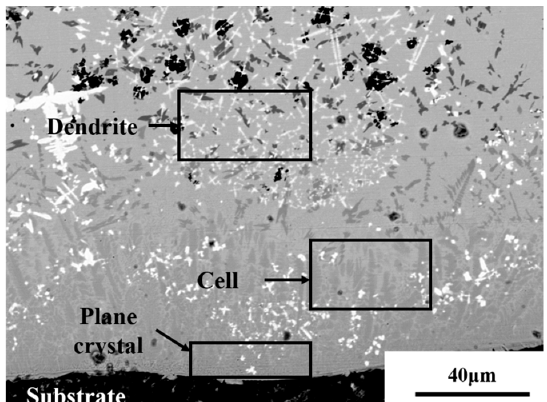
Figure 6. Schematic diagram of grain growth at the bottom of cladding layer.